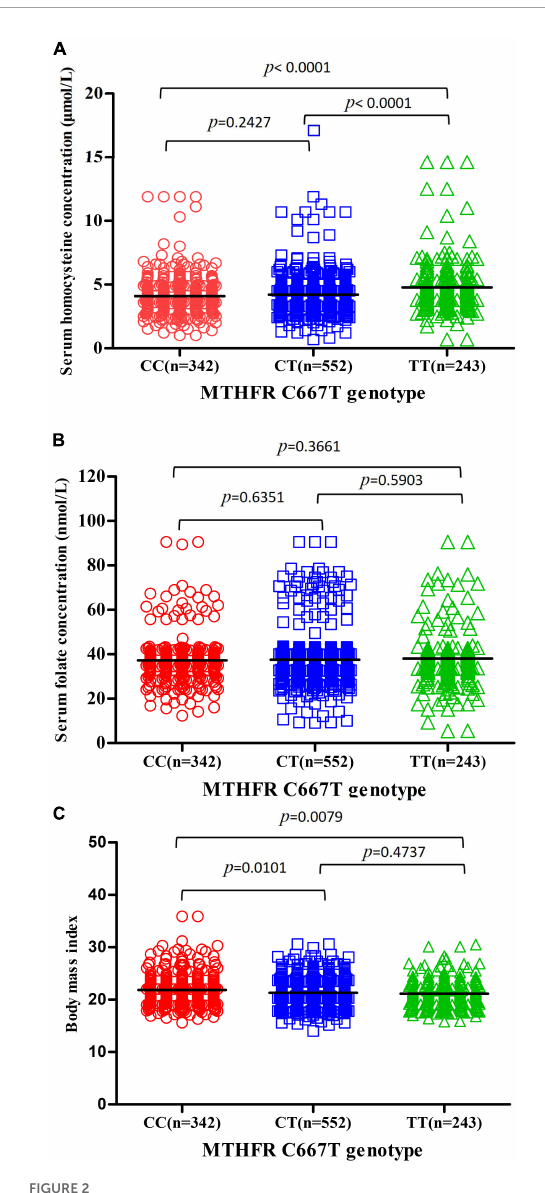
enzyme that influenced the relationship between folate